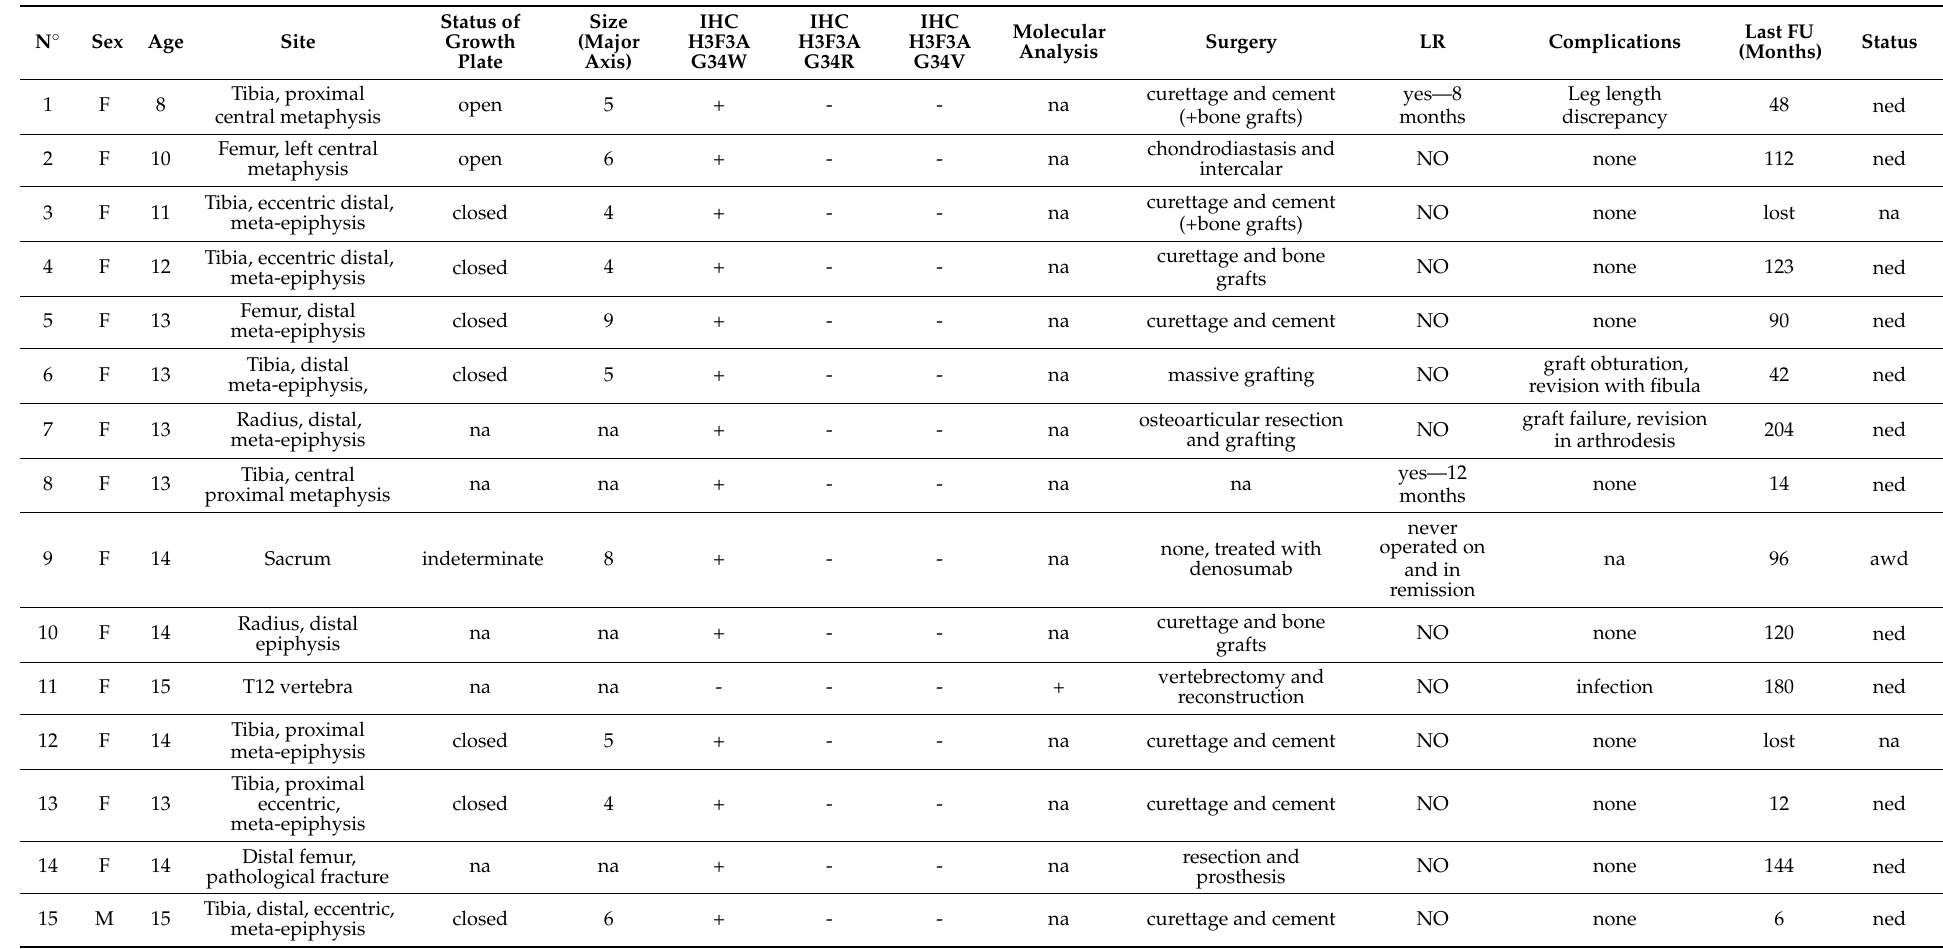
Table 1. Clinical, radiological, histological, immunohistochemical, and molecular features of the 15 patients are collected in the